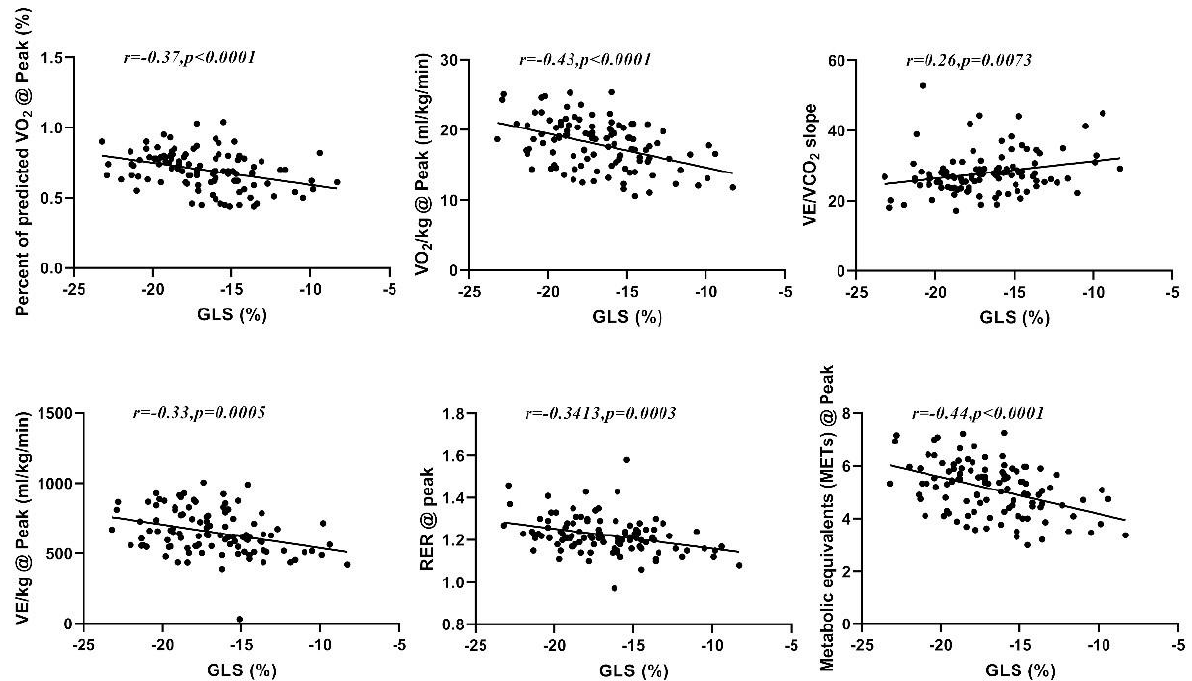
Figure 2. Correlation between GLS and %PPeak VO 2 , peak VO 2 , VE/VCO 2 slope, peak VE, peak RER, and peak METs. Table 3. Correlations between numerical parameters of CPX with the left ventricular ejection frac- tion (LVEF) and global longitudinal strain (GLS).